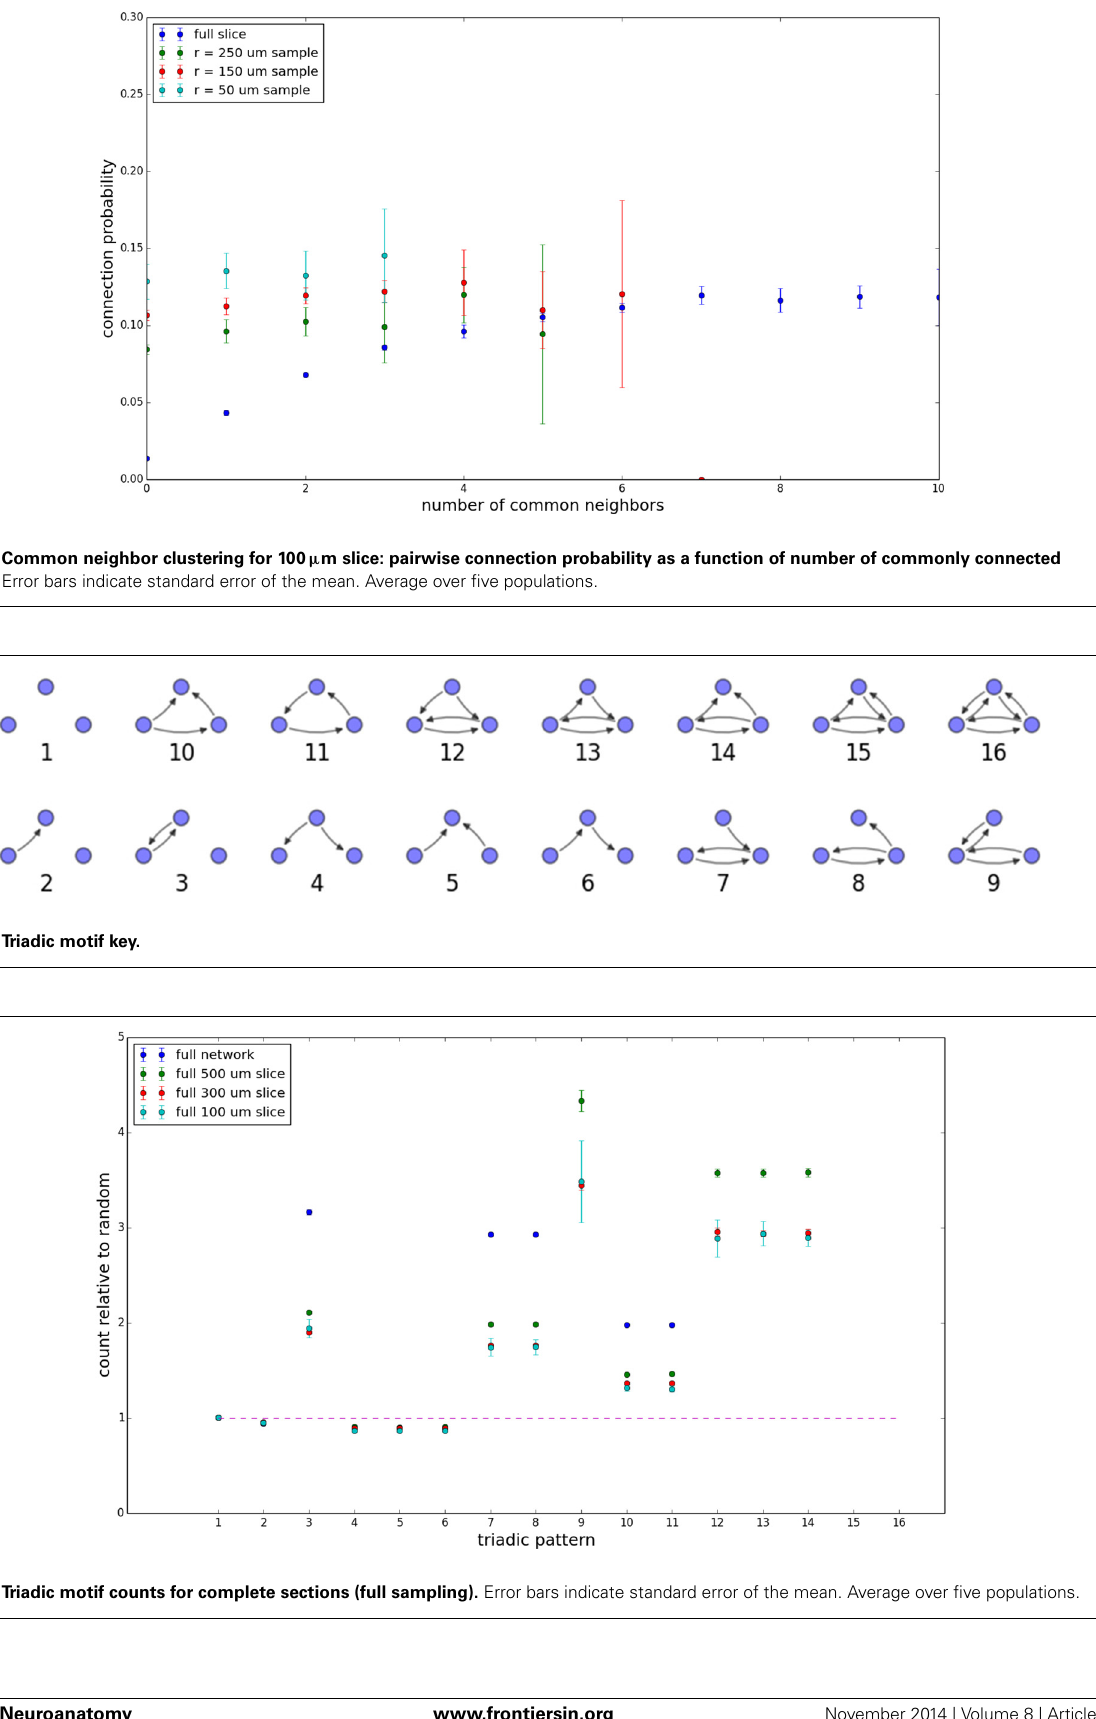
Frontiers in Neuroanatomy